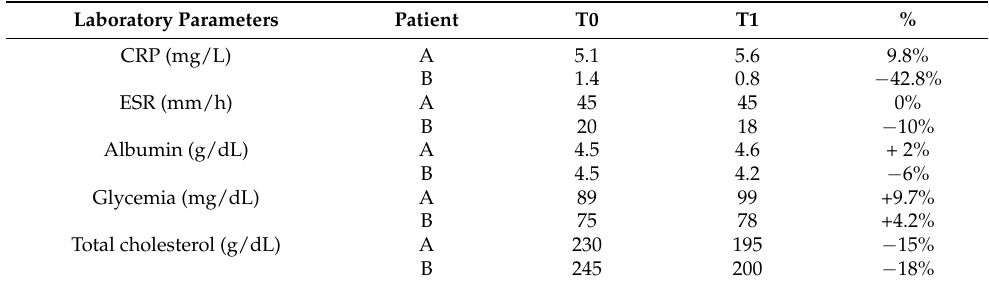
Table 4. Patient A and B laboratory parameters before (T0) and after (T1) interventions. The comparisons between pre- and post-intervention data are expressed by the percentage variation